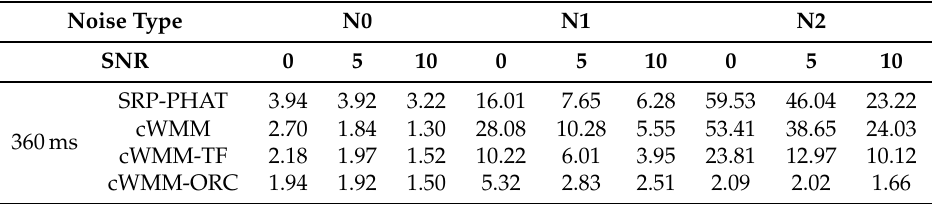
Table 3. The MAE ( ◦ ) of the algorithms in different test environments with competing